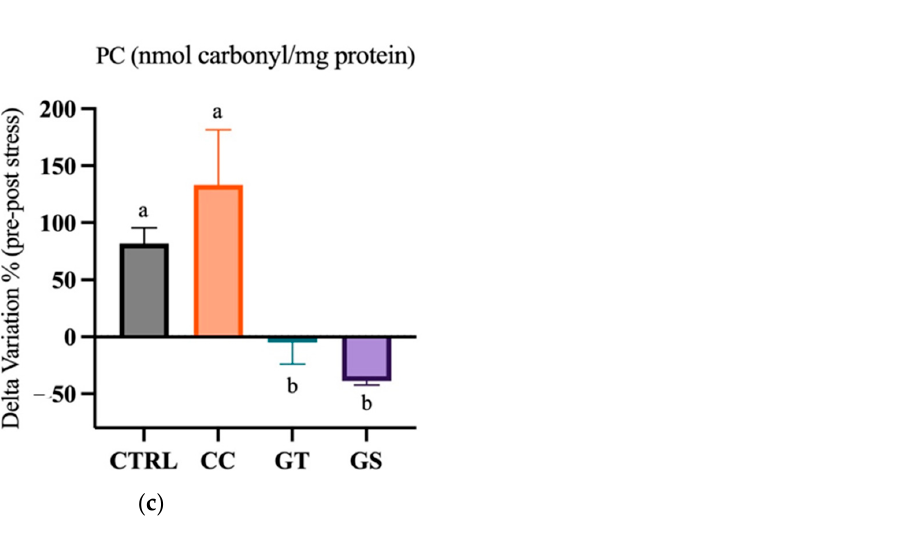
Figure 3. Delta variation (%) of the response of oxidative and cellular stress-related biomarkers ( a ) glutathione-s-transferase (GSH), ( b ) heat shock protein 70 (HSP70), and ( c ) protein carbonyl (PC) from standard to acute stress conditions of Senegalese sole fed with different diets (CTRL, CC, GT, and GS). Values are presented as means ± SD, n = 3. Different superscript letters indicate significant differences ( p < 0.05, 1-way ANOVA) between the dietary treatments.